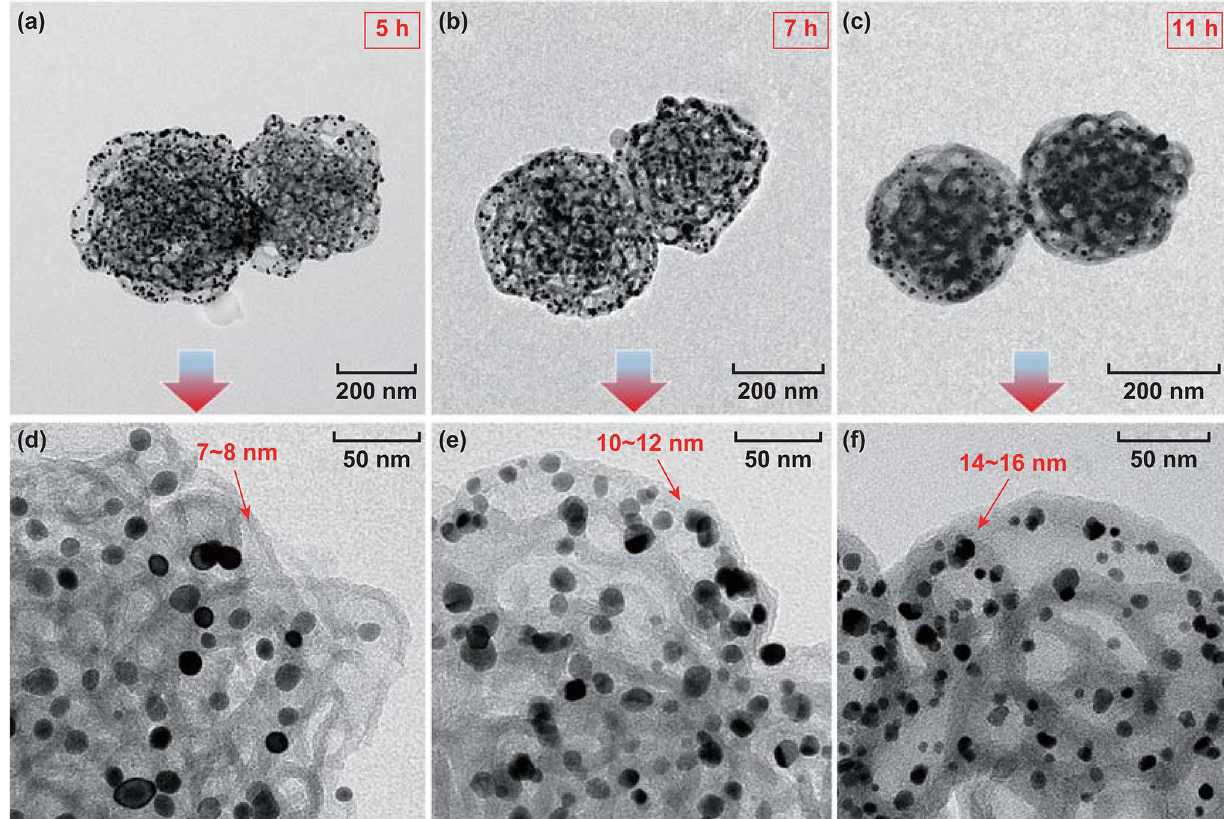
Fig. 3 TEM images of the Au@PDA porous particles with different thicknesses of the PDA layer by adjusting the reaction time from 5 h, 7–8 nm ( a , d ) to 7 h, 10–12 nm ( b, e ), and 11 h, 14–16 nm ( c , f